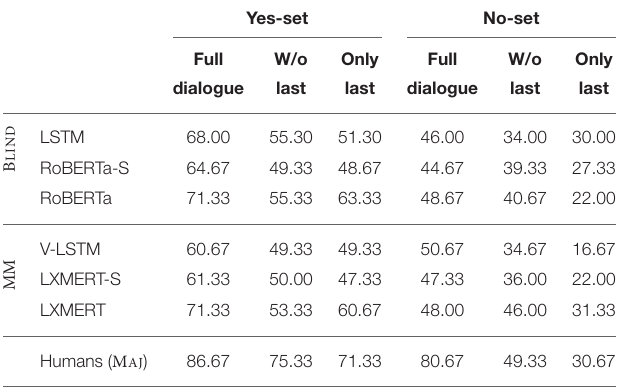
the error made by the model and the participant is